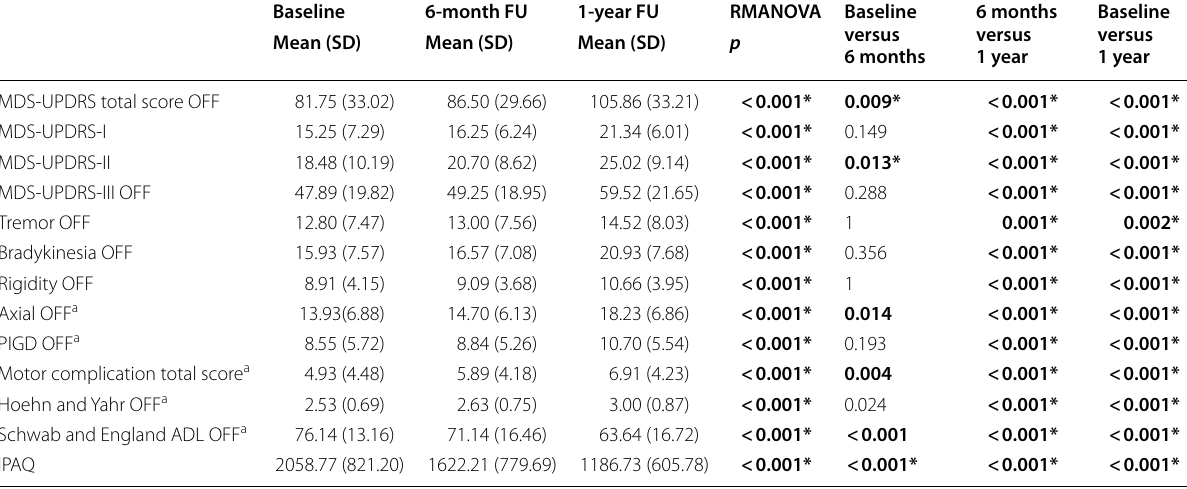
Bold values are significant